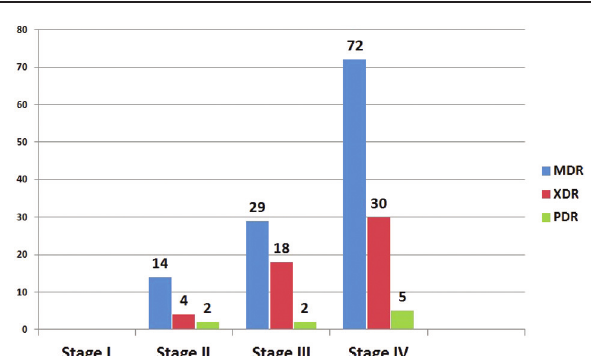
attacks. MDR, multidrug resistance; PDR, pandrug-resistance; XDR, extensive